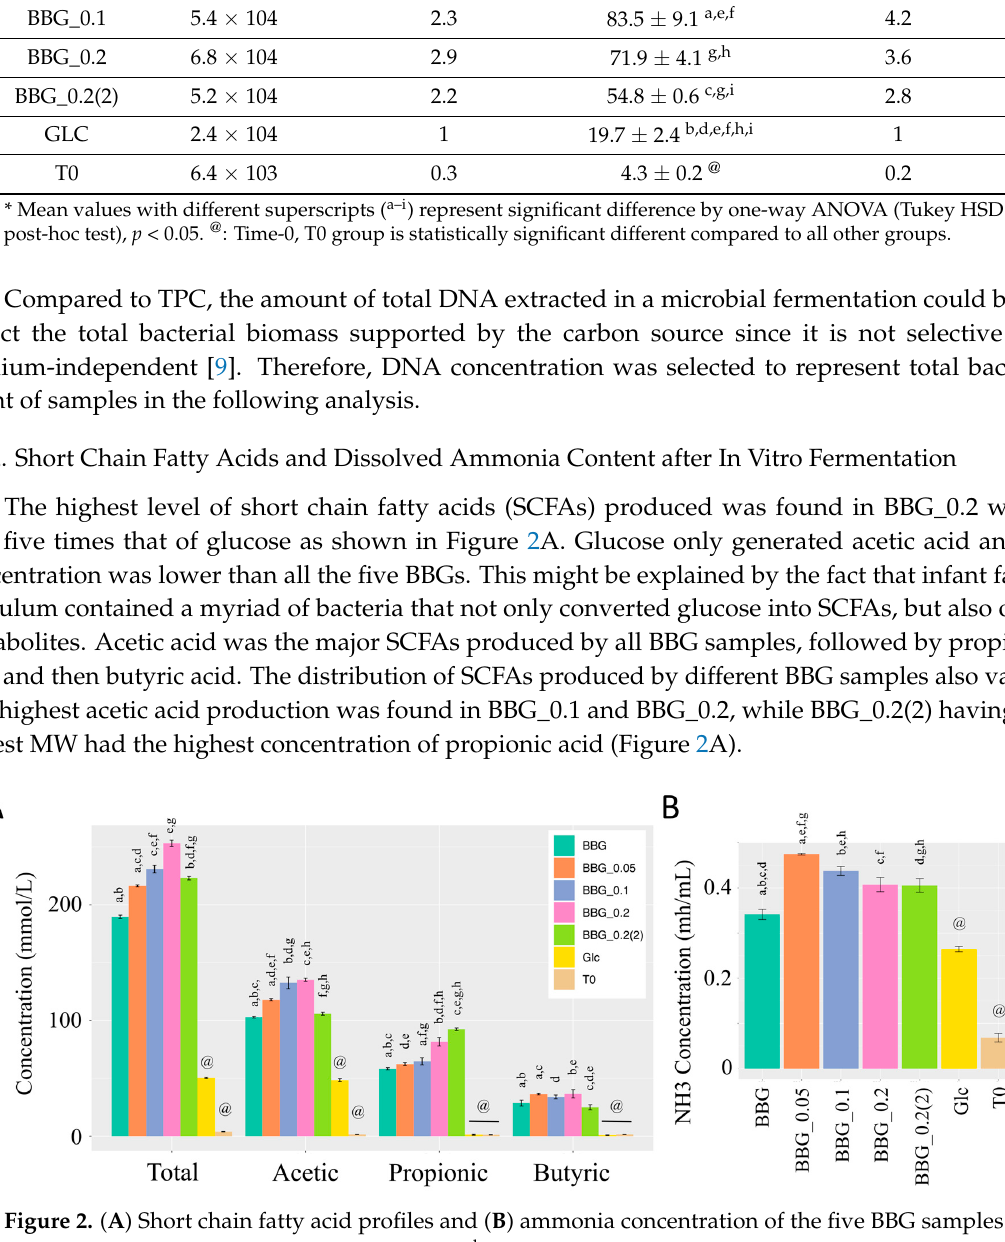
Table 3. Bacterial total plate count (CFUs) and concentration of total DNA extracted from culture broth of the infant faecal fermentation of five BBG samples, glucose monomer and time-0. Samples